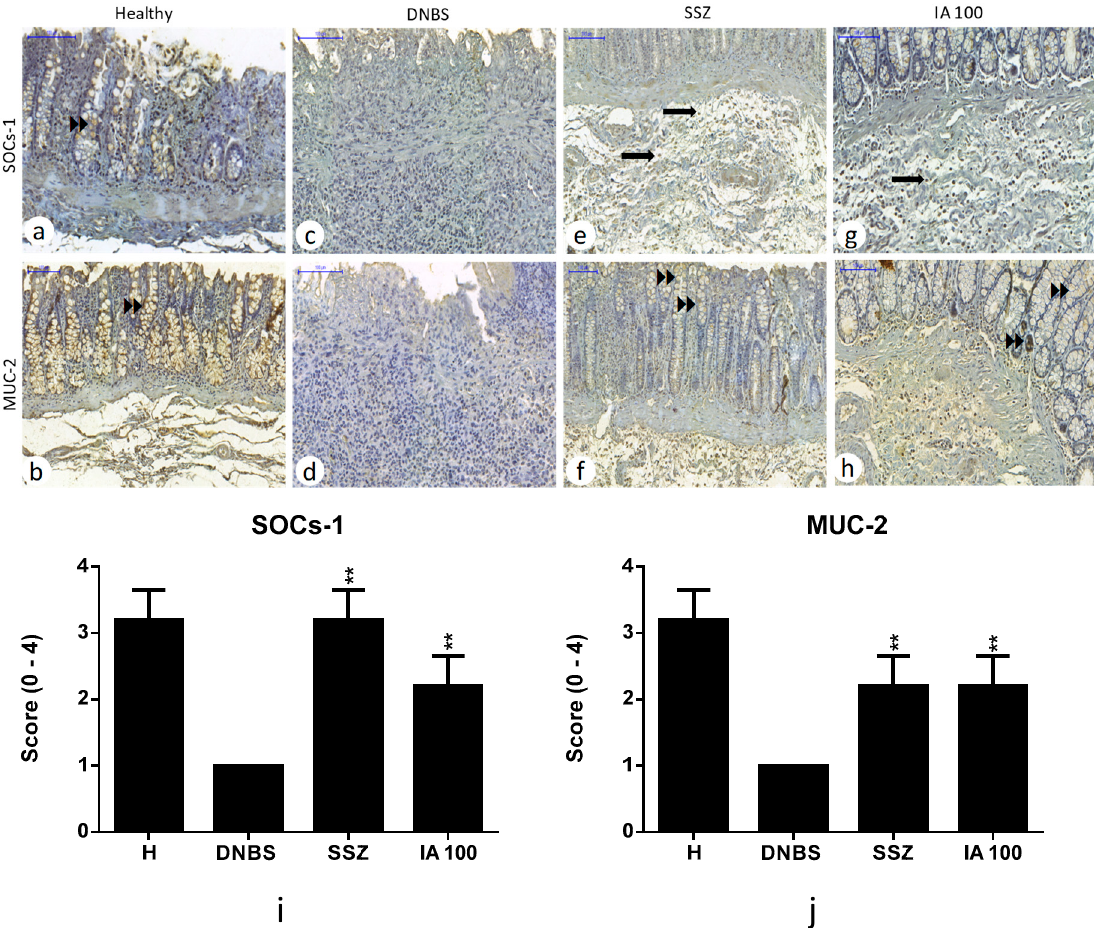
Figure 7. Immunohistochemical analysis of the effect of 25, 50, and 100 mg/kg doses of I. asarifolia (IA) aqueous extract, and 250 mg/kg of sulfasalazine (SSZ) on intestinal colon mucosa in an experimental trial of acute colitis induced by 2,4-dinitrobenzene sulphonic acid (DNBS) in rats. Immunoreactivity was recognized by brownish staining in inflammatory cells, regardless of whether in the nucleus or cytoplasm. Healthy group ( a , b ) exhibiting moderate immunoreactivity for cytokine-1 signaling suppressor (SOCs-1) and mucin-2 (MUC-2) in the epithelium ( (cid:73)(cid:73) ). DNBS control ( c,d ), exhibiting no immunoreactivity for SOCs-1 and MUC-2. SSZ group with moderate immunoreactivity for SOCs-1 and discreet for MUC-2 ( e,f ). Group IA 100 mg/kg with mild immunoreactivity for SOCs-1 and MUC-2 ( g,h ). Inflammatory cells ( (cid:225) ). Immunoreactivity score ( i,j ). H, Healthy group; DNBS, DNBS group; SSZ, Sulfasalizine group; and 25, 50, and 100 mg/kg doses of IA. Expressed as mean ± SEM, ( n = 5). The statistical differences ** p < 0.01 of the treatments are presented vs DNBS control (Scanner Panoramic Viewer, 100×).